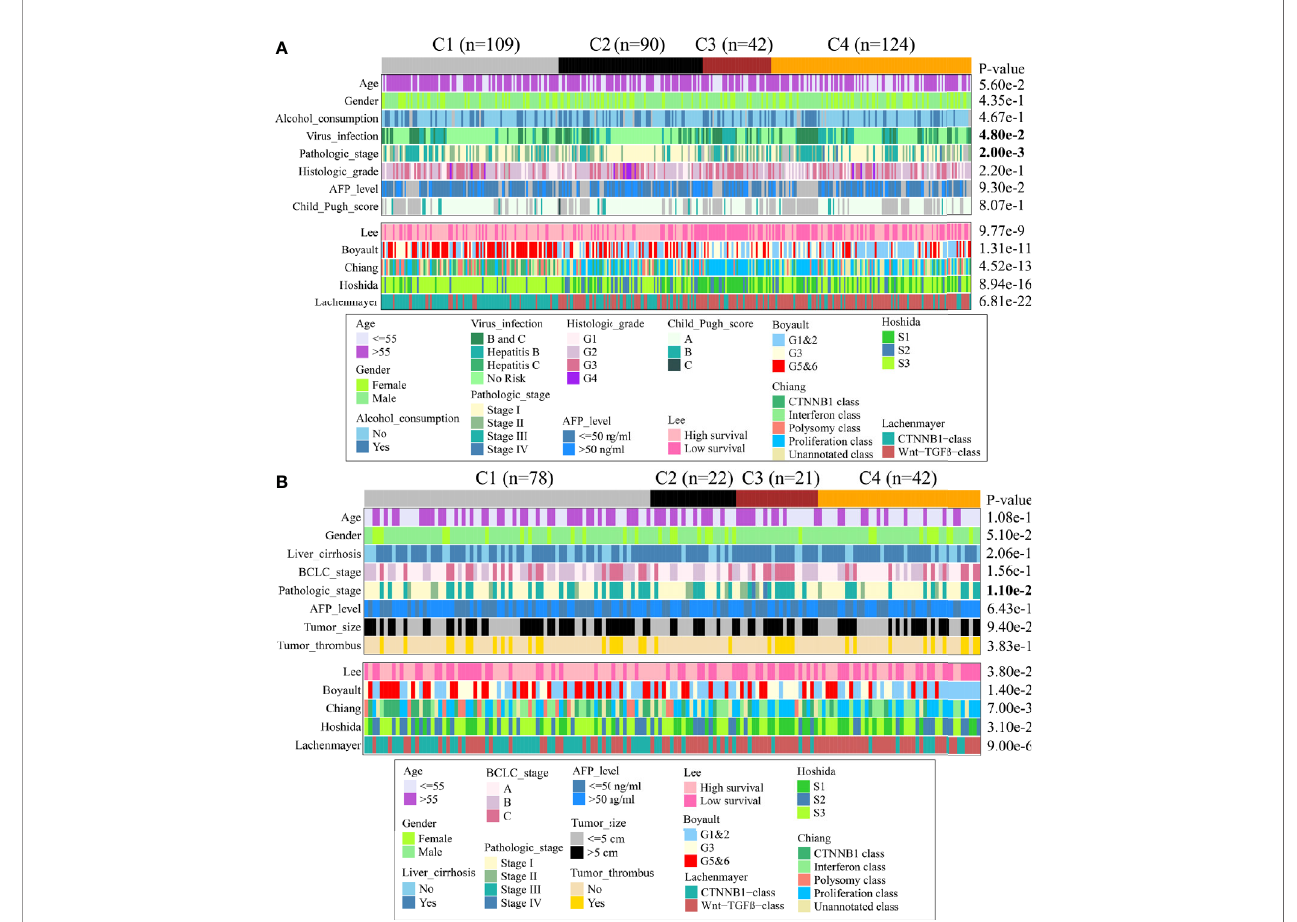
FIGURE 4 | Clinical characteristics of four immune subclasses. Correlation of the immune subclass with clinical characteristics and previously reported HCC classi fi cation in TCGA cohort (A) and CHCC-HBV cohort (B)